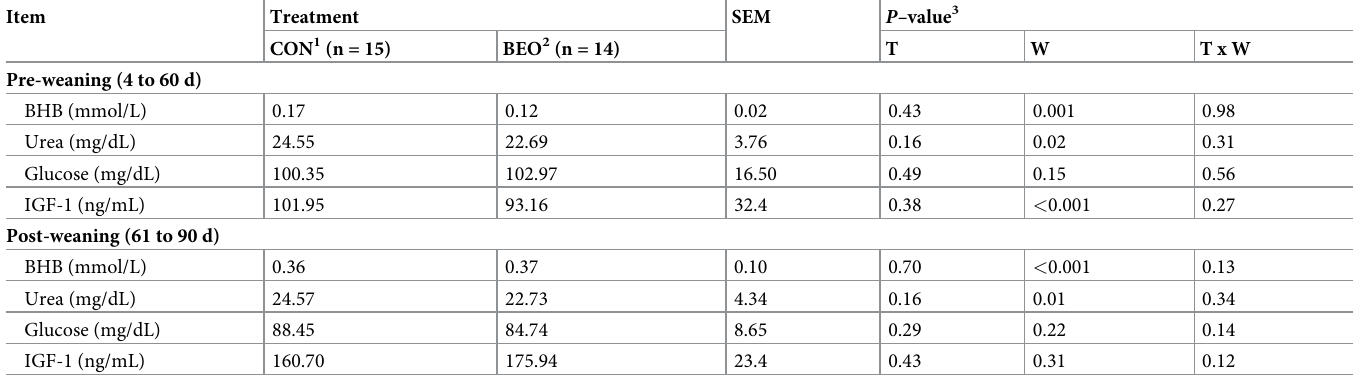
Table 5. Pre- and post-weaning mean blood concentrations of insulin growth factor type 1 (IGF-1) and metabolites of control heifers (CON) and heifers supple- mented with a blend of essential oils blend (BEO) in milk replacer during